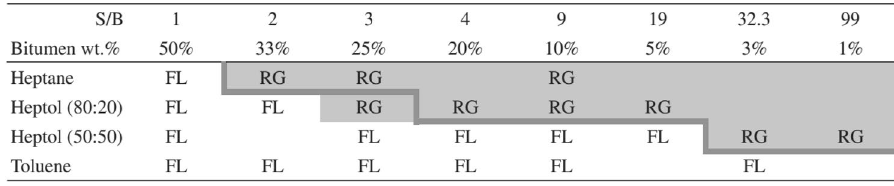
Table 2 Solvent-to-bitumen ratio at which asphaltene is instable ( Tchoukov et al. 2010)